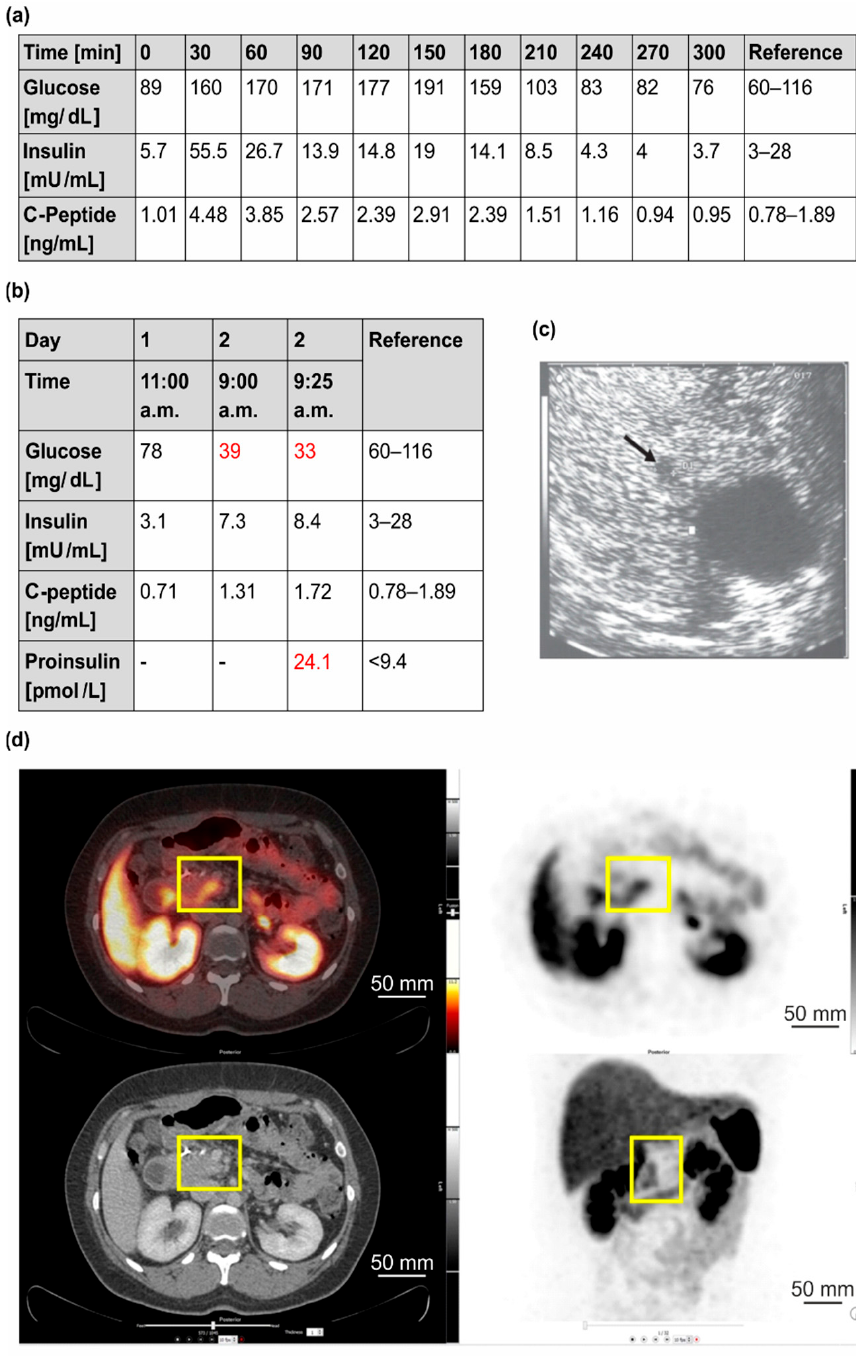
Figure 2. Laboratory tests and diagnostic imaging of case 1 (index patient, IV4). ( a ) Endocrine testing showed unremarkable oral glucose tolerance (prolonged test conditions) without clinical or biochemical signs of hypoglycemia. ( b ) A 72 h fasting test showed marked hypoglycemia after 22 h with a plasma glucose as low as 33 mg/dL and corresponding serum C-peptide, insulin, and proinsulin levels inadequately elevated. (- = not performed). Values outside the reference range are highlighted in red. ( c ) Further imaging with endoscopic ultrasound revealed a single lesion of 4–5 mm. ( d ) Functional imaging with 68Ga-DOTATOC-PET/CT was negative with low and diffuse uptake in the pancreatic head (yellow frames), interpreted as unspecific.